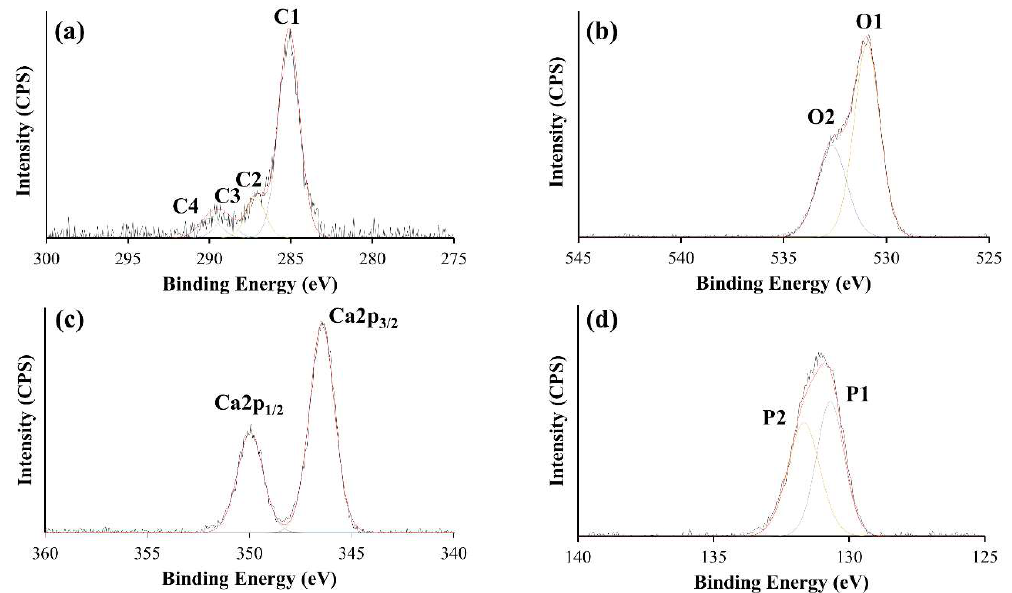
Figure 8. High-resolution peak fitted XPS spectra for the as-deposited HA600 thin film. ( a ) C 1 s , ( b ) O 1 s , ( c ) Ca 2 p , and ( d ) P 2 p .